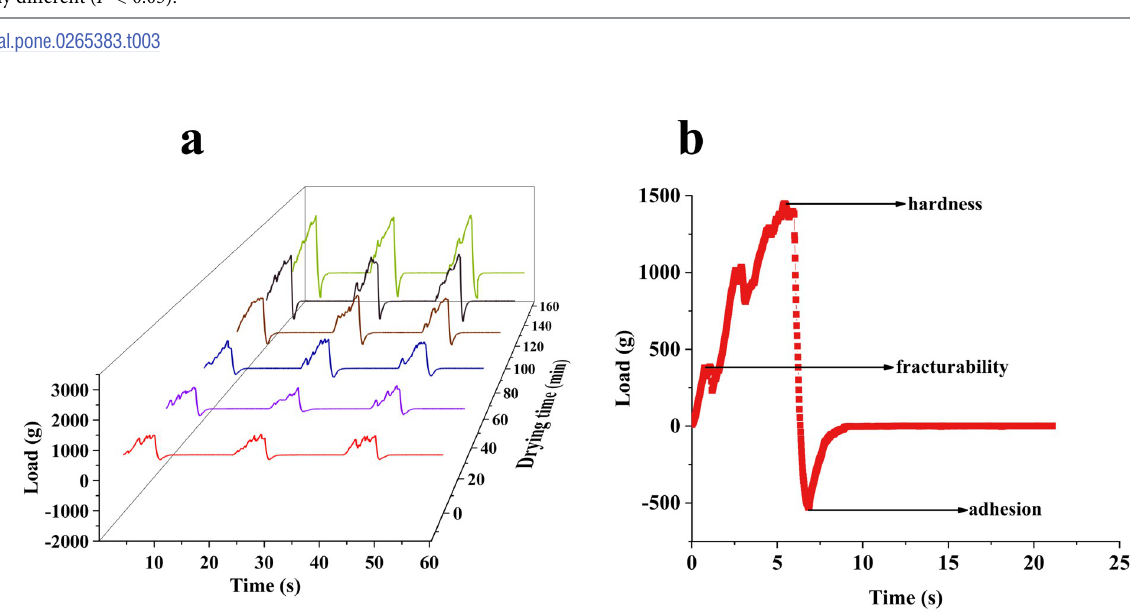
Fig 5. Load curves for AR pieces during drying. (a): Samples at different drying times. (b): One complete